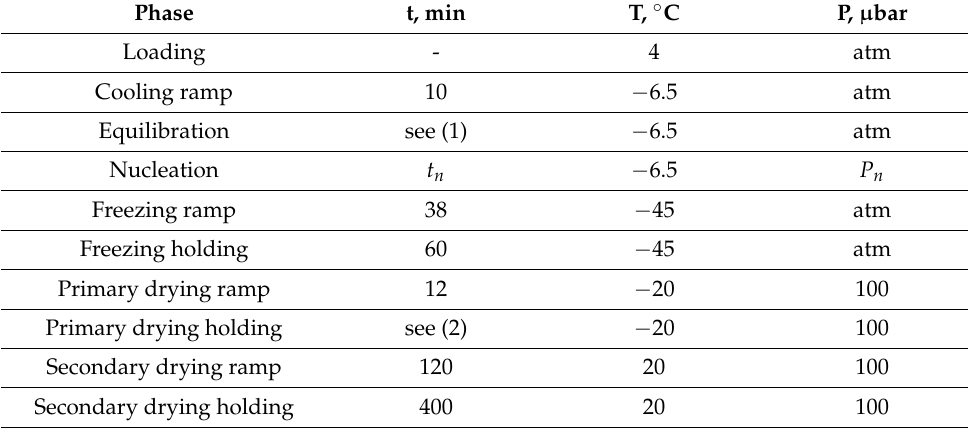
Table 1. Details of the freeze-drying cycles performed in the present